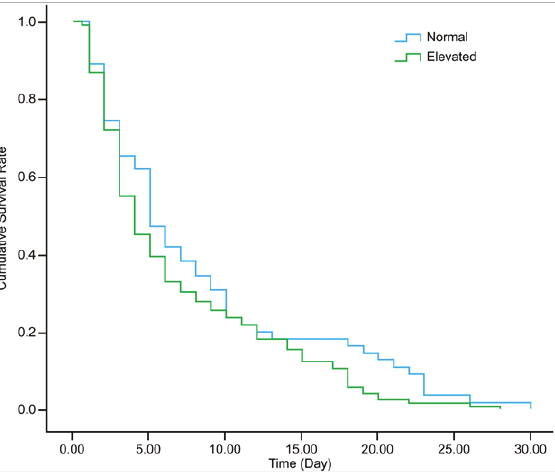
Figure 1: The impact of consciousness disturbance on the survival rate of young adult patients with intracranial hemorrhage. Patients with consciousness disturbance following cerebral hemorrhage showed shorter survival times and a higher risk of death.